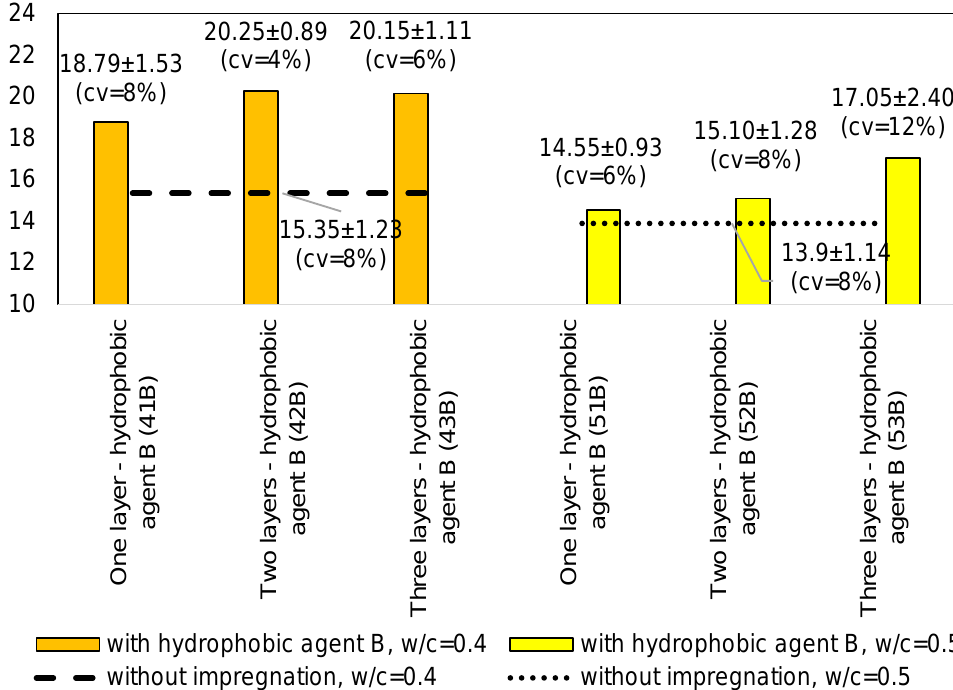
Figure 5. Rebound number comparison for samples with different w/c and impregnation using hydrophobic agent A. Rebound number comparison for samples impregnation using hydrophobic agent B presents Figure 6. For hydrophobic agent A the use of more than two layers does not in- crease the rebound number. Hydrophobic agent B is more effective for samples with a higher w/c ratio. It is visible that with increasing number of impregnation layers, the hard- ness also increase.